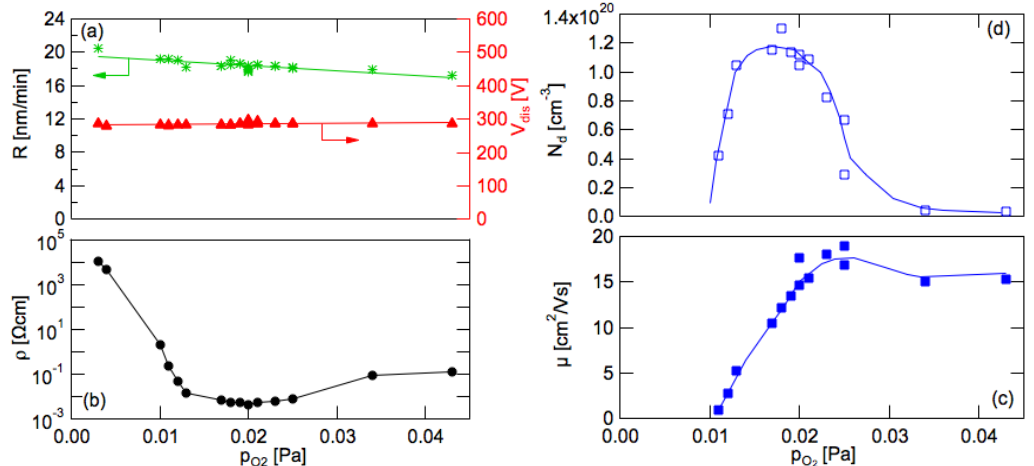
Figure 3. ( a ) Deposition rate (green) and discharge voltage (red), ( b ) resistivity ( c ) mobility and ( d ) carrier concentration as a function of the reactive gas partial pressure. Deposition parameters: P DC = 25 W, p total = 0.5 Pa, reactive gas: O 2 , RT deposition. The lines in ( a ) are linear fit curves, while the lines in ( b – d ) are thought of as guides to the